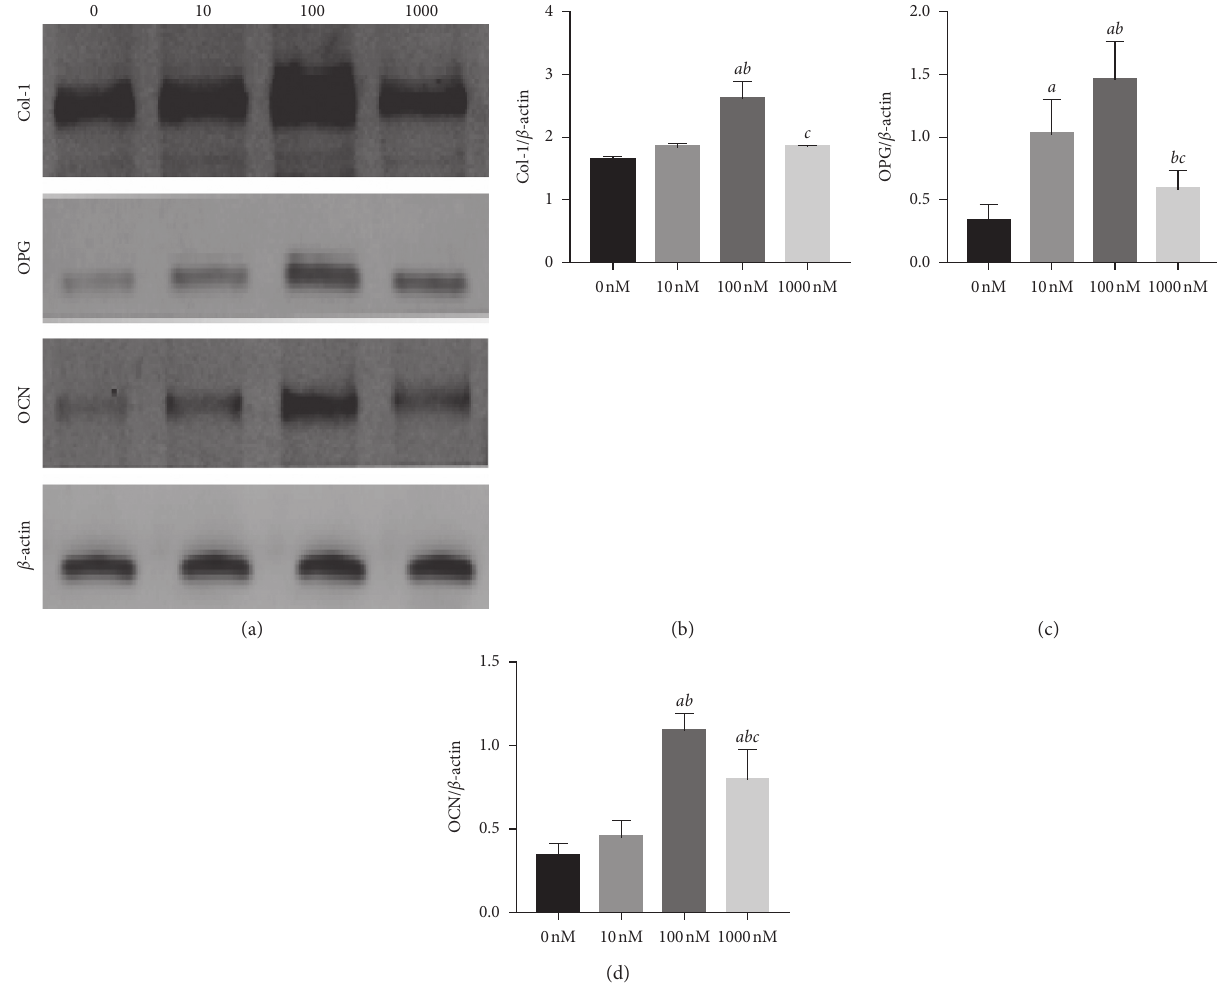
Figure 5: Liraglutide upregulated Col-1, OPG, and OCN protein expression. MC3T3-E1 cells were treated with different concentrations of liraglutide for 48h, and then the protein expression of Col-1, OPG, and OCN was measured by western blot (a). Quantitative analysis of the protein level of Col-1 (b), OPG (c), and OCN (d) in MC3T3-E1 cells after treatment with liraglutide for 48h. aP < 0.01 compared with 0nM, bP < 0.01 compared with 10nM, and cP < 0.01 compared with